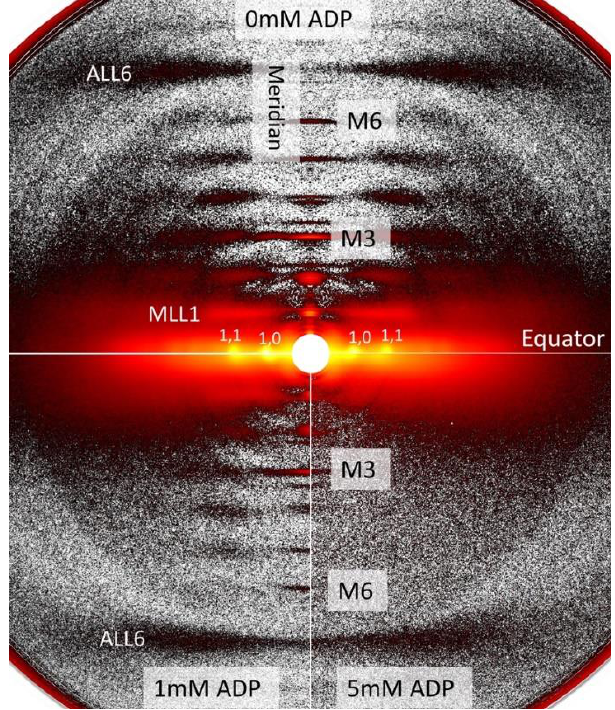
Figure 1. Representative X-ray diffraction patterns from permeabilized porcine myocardium at different concentrations of ADP. Characteristic relaxed patterns with intense layer line reflections in the absence of ADP (top panel). The myosin-based layer lines (e.g., MLL1) become weaker at 1 mM ADP (bottom left panel), and disappeared completely at 5 mM ADP (bottom right panel). The sixth order actin-based reflection (ALL6) remained relatively unchanged with changes in [ADP].